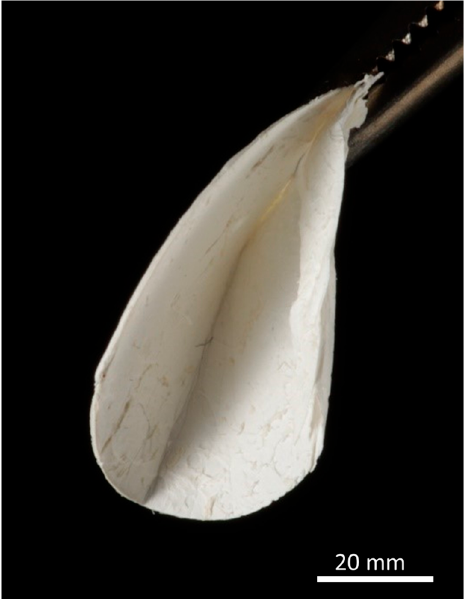
Figure 1. An electrospun BTCP-AE-FM folded in half.